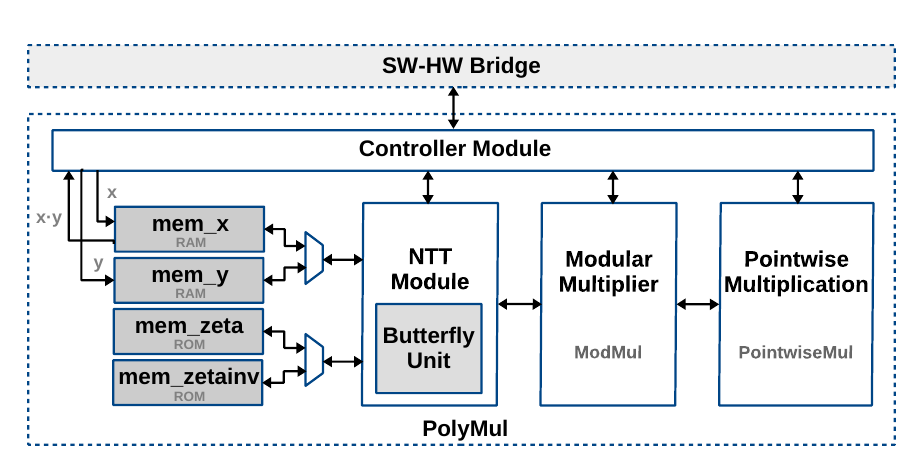
Figure 3: Dataflow diagram of the PolyMul hardware